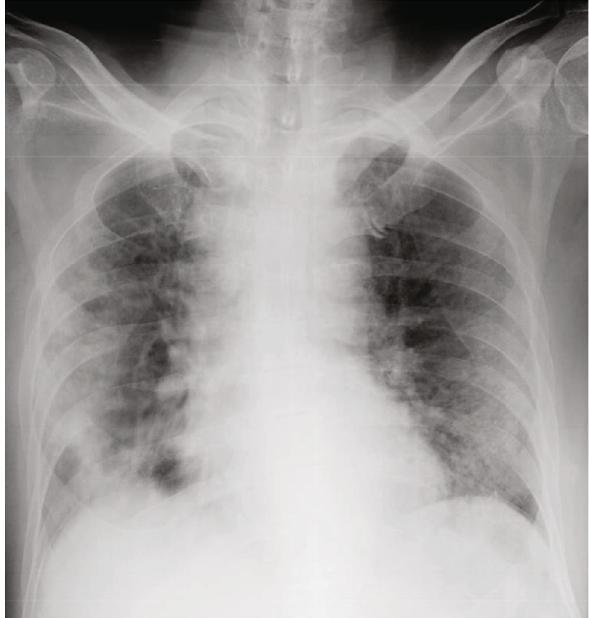
Figure 8: Chest radiograph of case 4 on day 2 in the ICU showing worsening of air space opaci fi